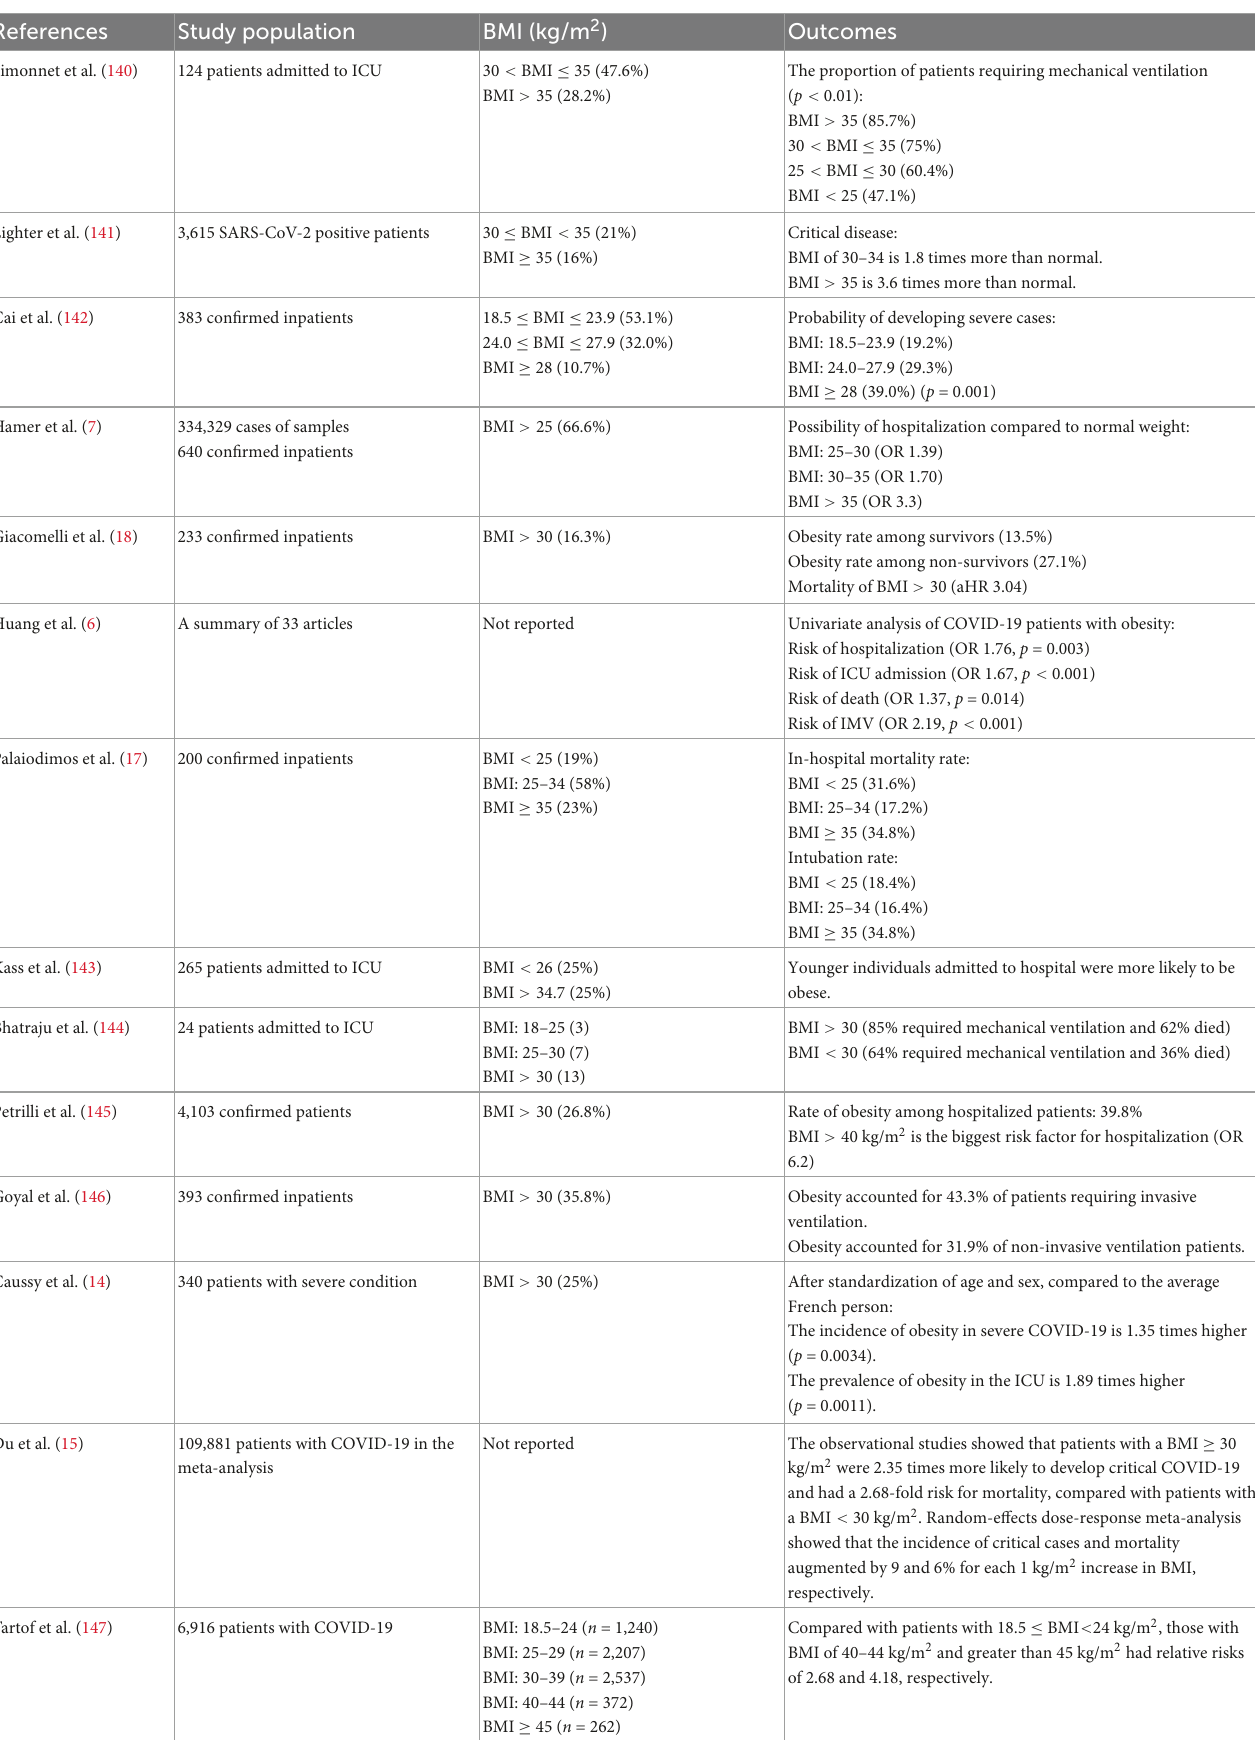
TABLE 1 Studies reporting on the outcomes of obese patients with